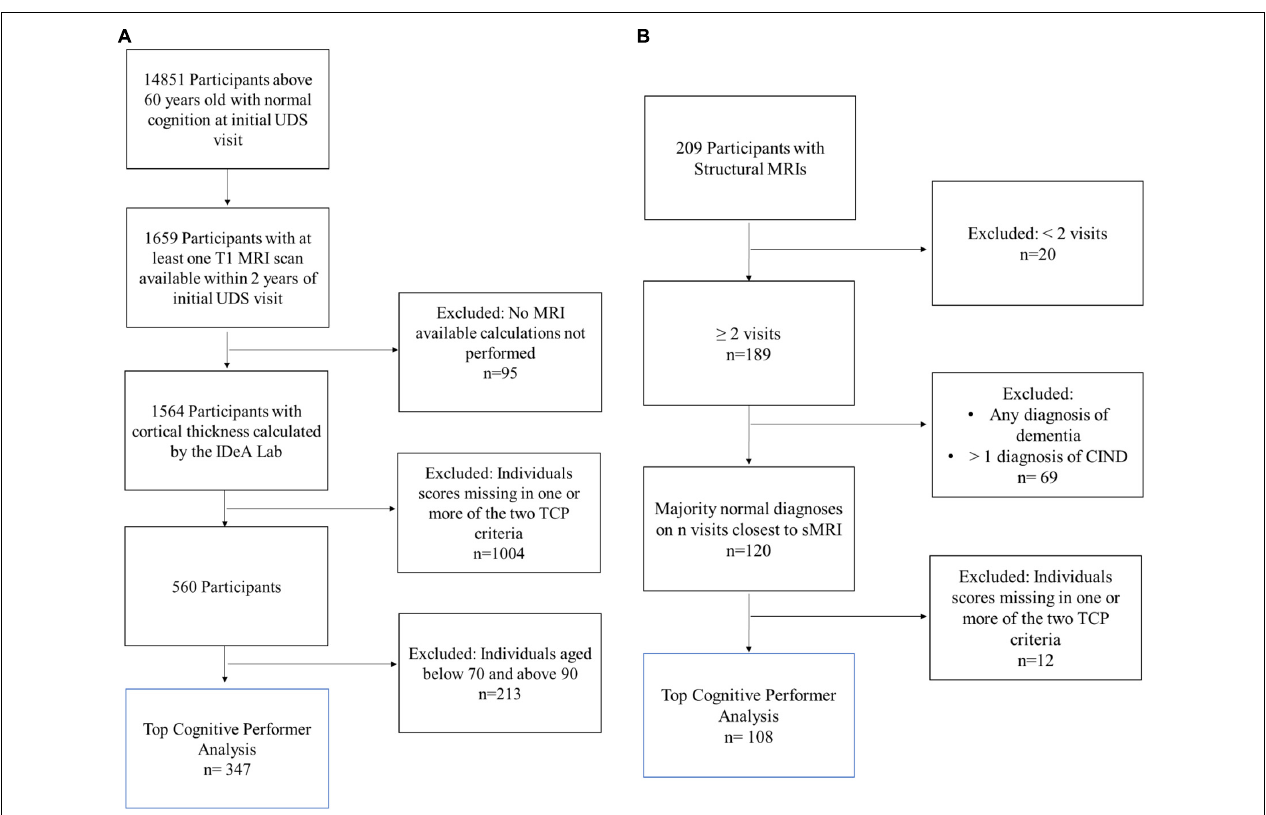
FIGURE 1 | Inclusion flow chart for (A) NACC and (B) The 90 + Study Participants. Blue box reflects the participants included in the final analysis of top cognitive performers (TCP).